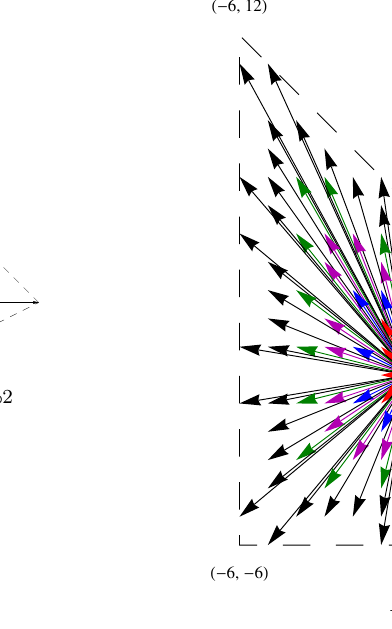
Figure 2 . The base B = P 2 and the base ~ B of the mirror of the generic elliptic (cid:12)bration over B , shown as toric varieties. Rays that are red, blue, purple, green correspond to curves in the